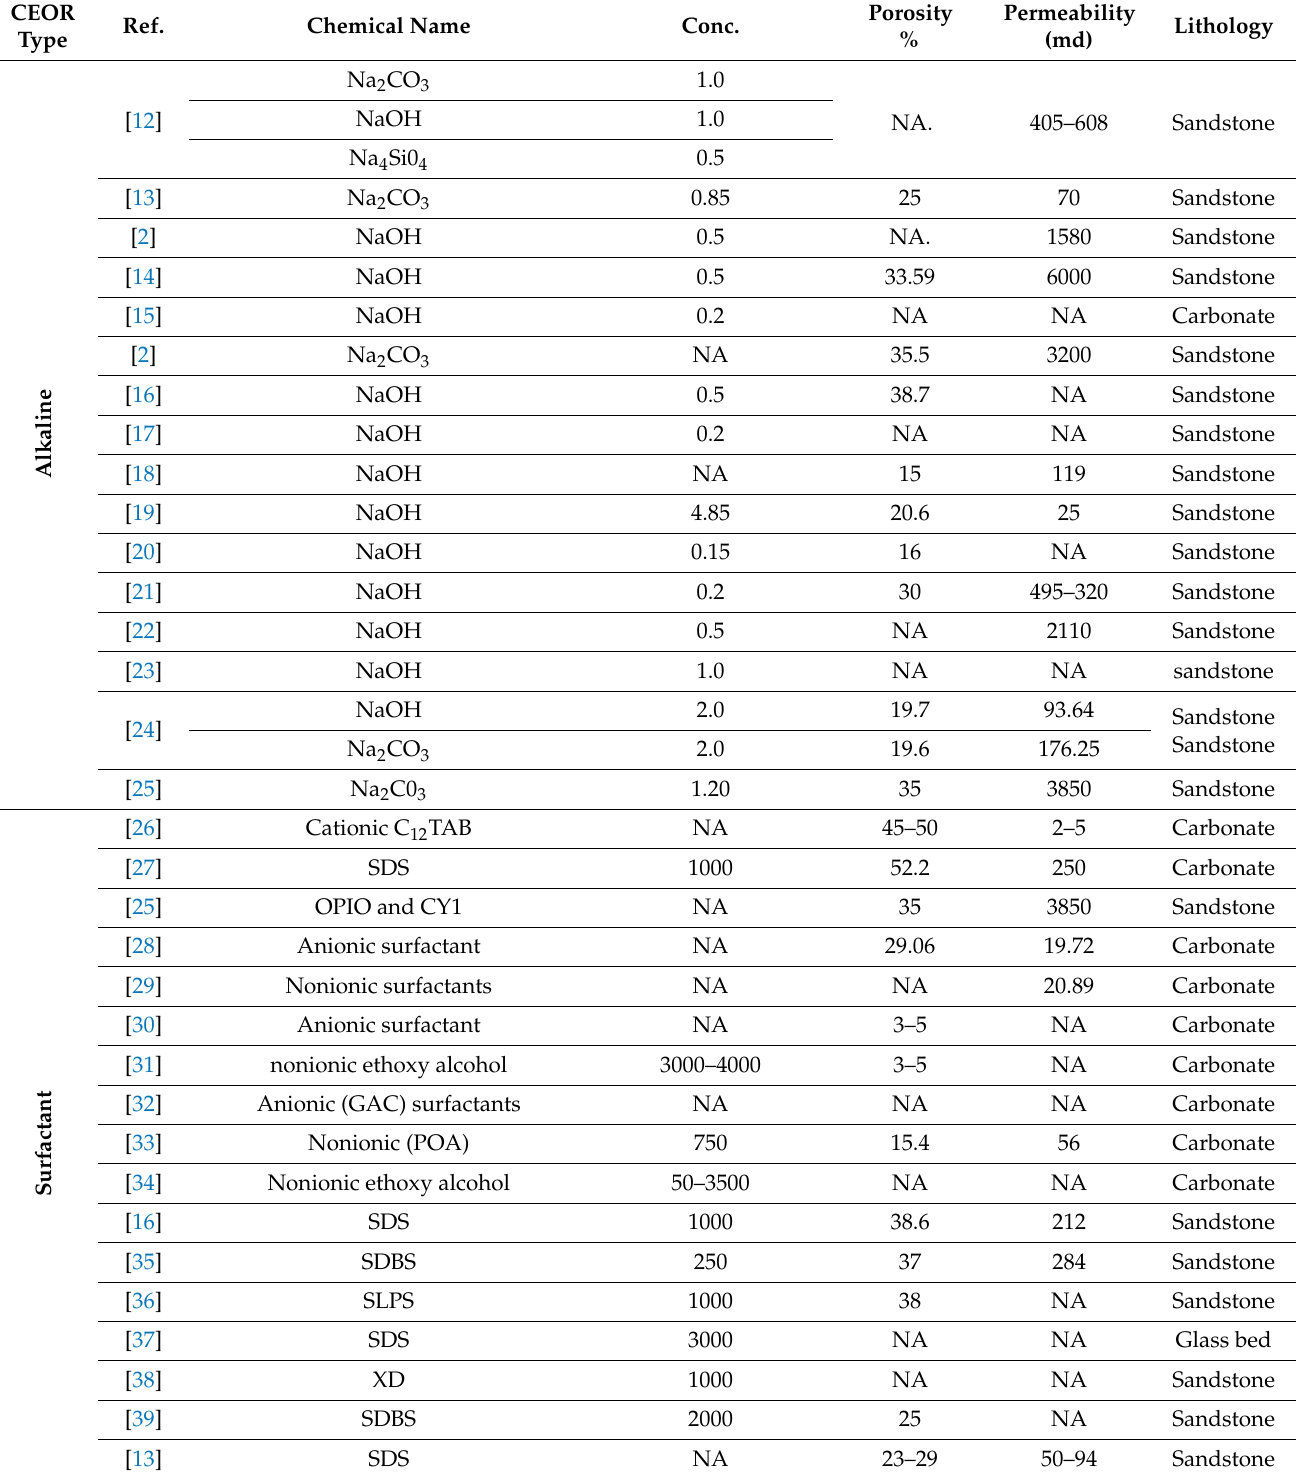
Table 1. Summary of previous experimental and field ASP works alone and in synergy.